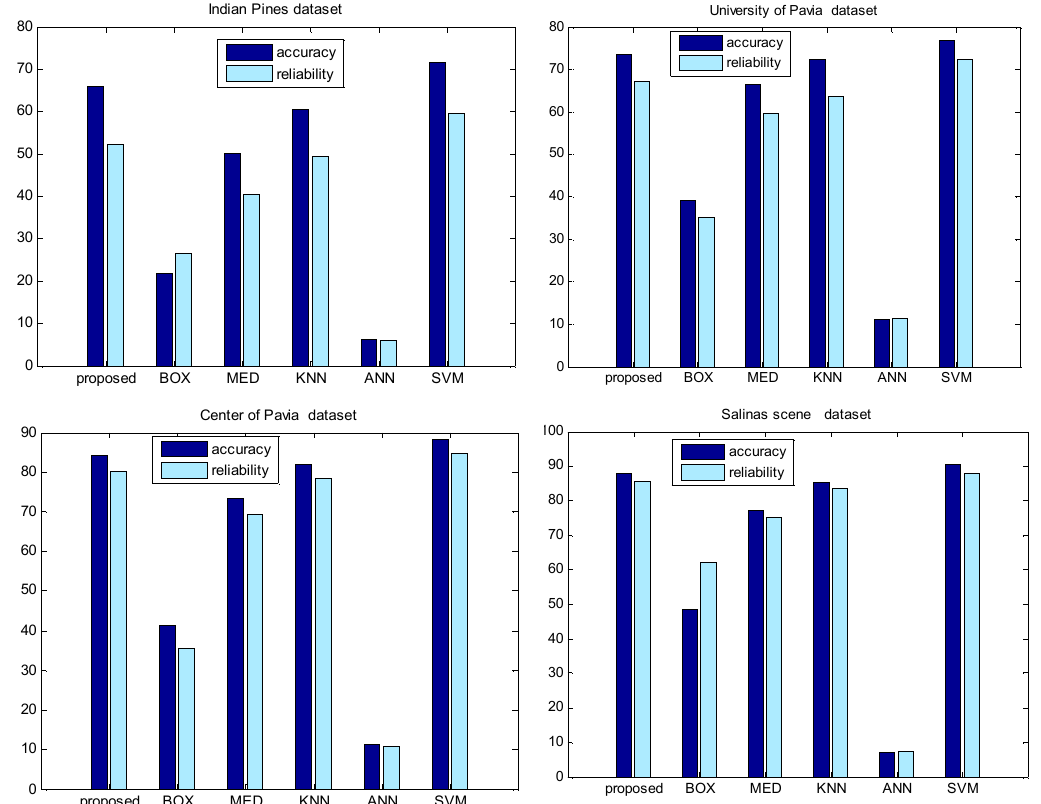
Figure 3. Comparison of accuracy and reliability of Indiana, university of Pavia, center of Pavia and Salinas datasets